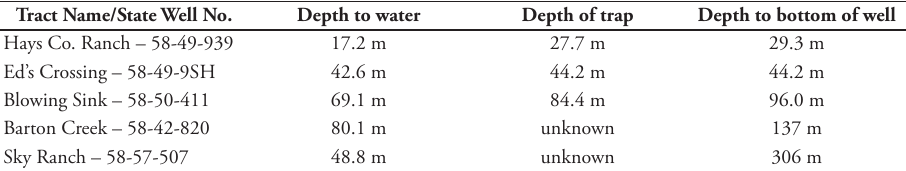
Table 3. Well Information. Data on sampled wells collected in the field and from the TWDB database. Tract names correspond to City of Austin WQPL tracts. The depth of trap in State Well No. 5857507 (Sky Ranch Tract) was not recorded. Water depth measurements were taken in the fall of 2017. Tract Name/State Well No. Depth to water Depth of trap Depth to bottom of